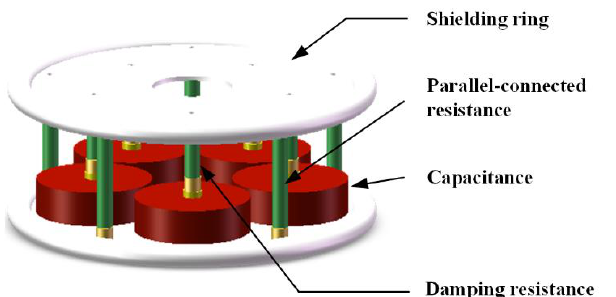
Figure 2. Structure of the high-voltage unit.